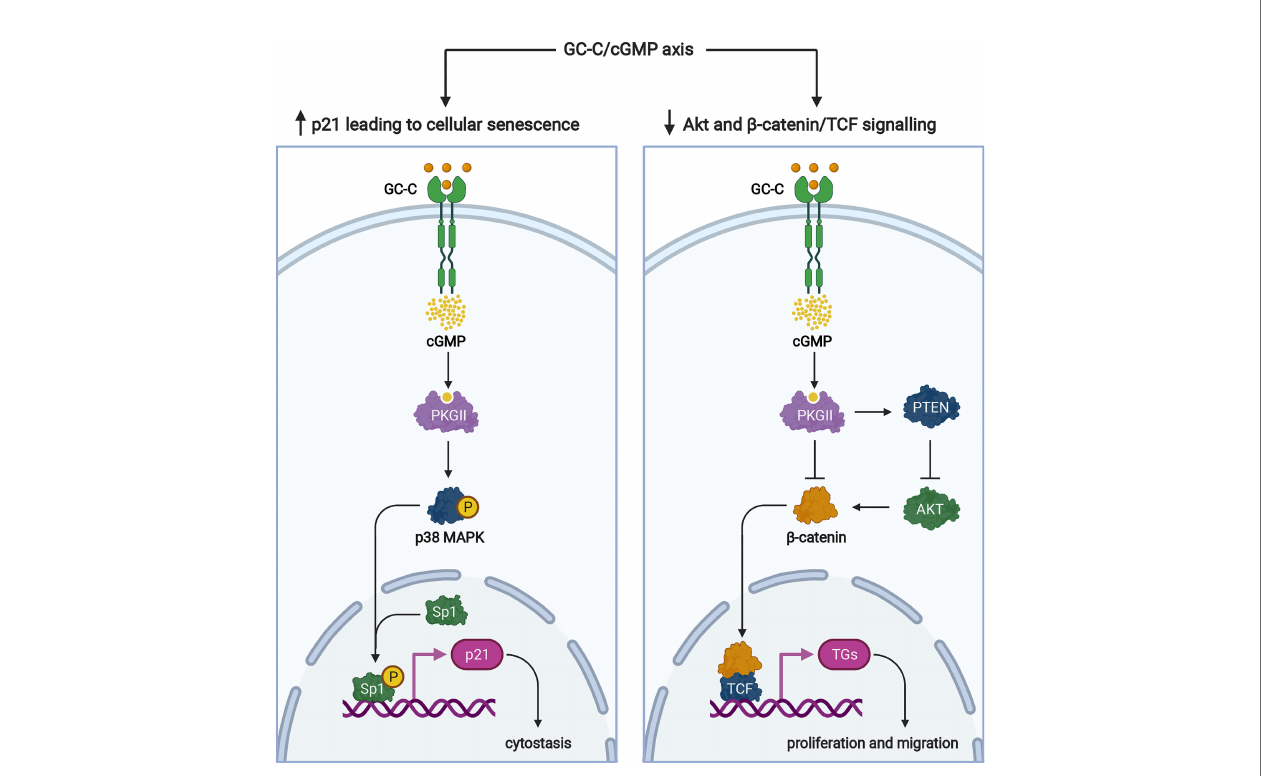
FIGURE 4 | Signaling pathways of the GC-C/cGMP axis that regulate cellular proliferation. Ligand-mediated activation of GC-C increases intracellular cGMP. Cyclic GMP production activates PKGII and p38 MAPK resulting in phosphorylation of the Sp1 transcription factor. Sp1 upregulates the expression of p21 and mediates cytostasis. PKGII-mediated signaling opposes pro-survival and pro-proliferative phenotypes mediated by the b -catenin/TCF and Akt pathways. Increased GMP activates cyclic nucleotide-gated ion channels (CNG), promoting Ca 2+ -in fl ux that mediates cytostasis and recruiting calcium-sensing G-protein coupled receptors (CaR) to the plasma membrane. TGs denotes target genes. The fi gure was prepared using